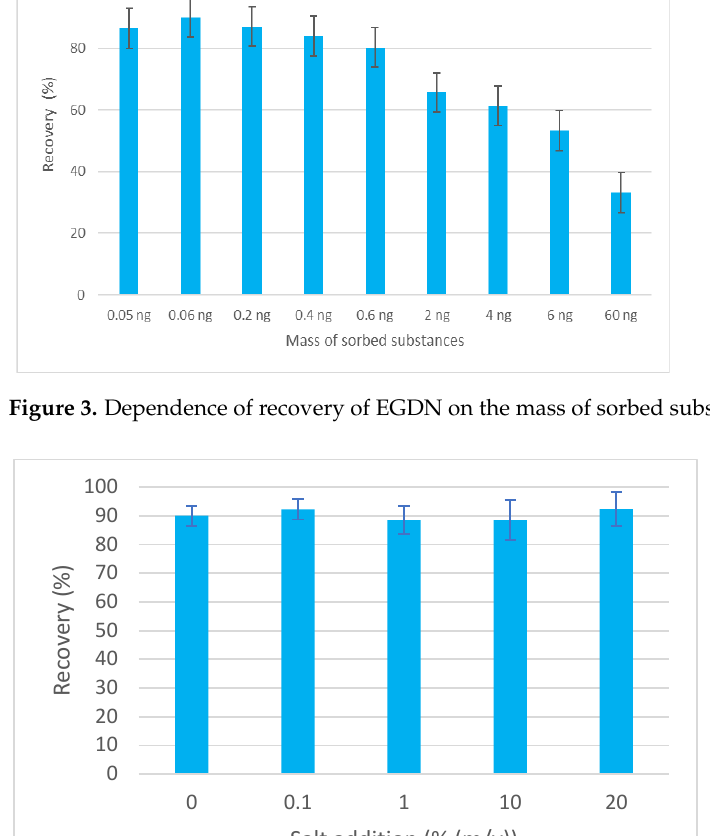
Figure 3. Dependence of recovery of EGDN on the mass of sorbed substances.